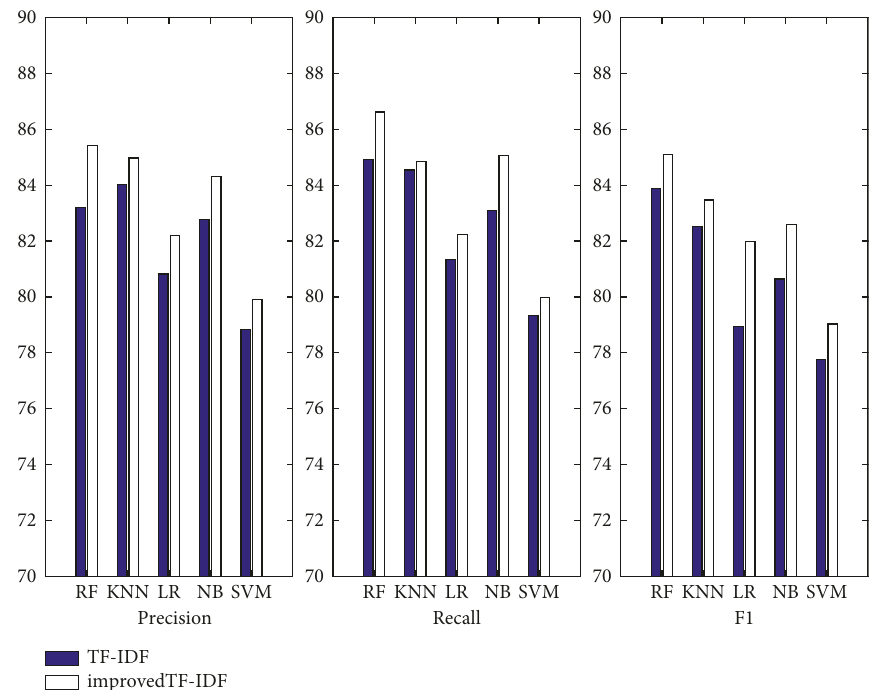
Figure 5: Comparison of indicators under different feature weight algorithms and